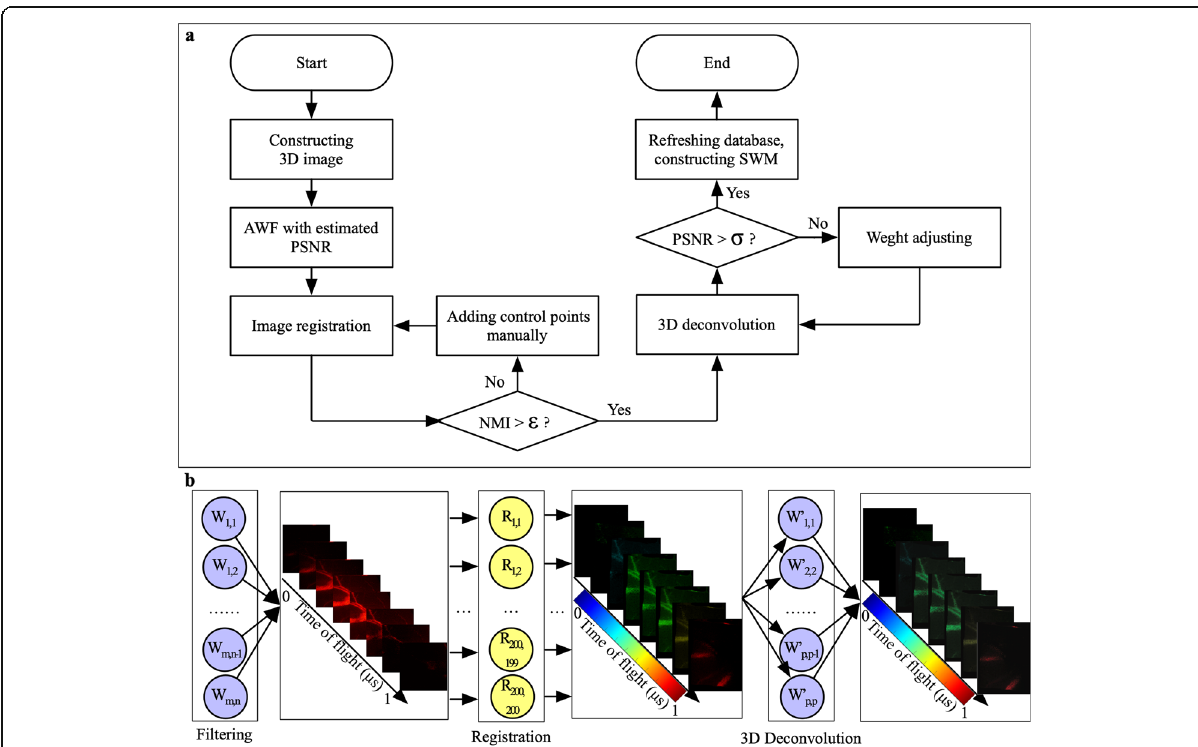
Fig. 2 Overall design of SWM. a : Flowchart of constructing SWM; b : Image processing flow through an SWM hierarchical structure. AWF: Adaptive Wiener filtering; NMI: Normalized mutual information; PSNR: Peak signal-noise-ratio; W i , j : The element in an adaptive Wiener filter; R i , j : The element in a registration matrix; W 0 i ; j : The element in a deconvolution kernel